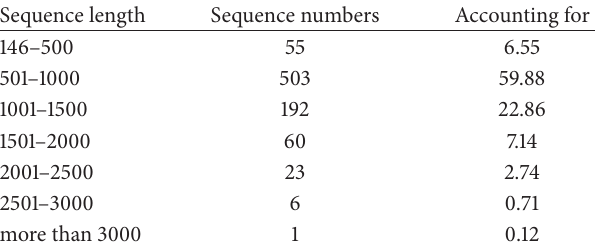
Figure 6: Pentanucleotide repeats of Unigene.